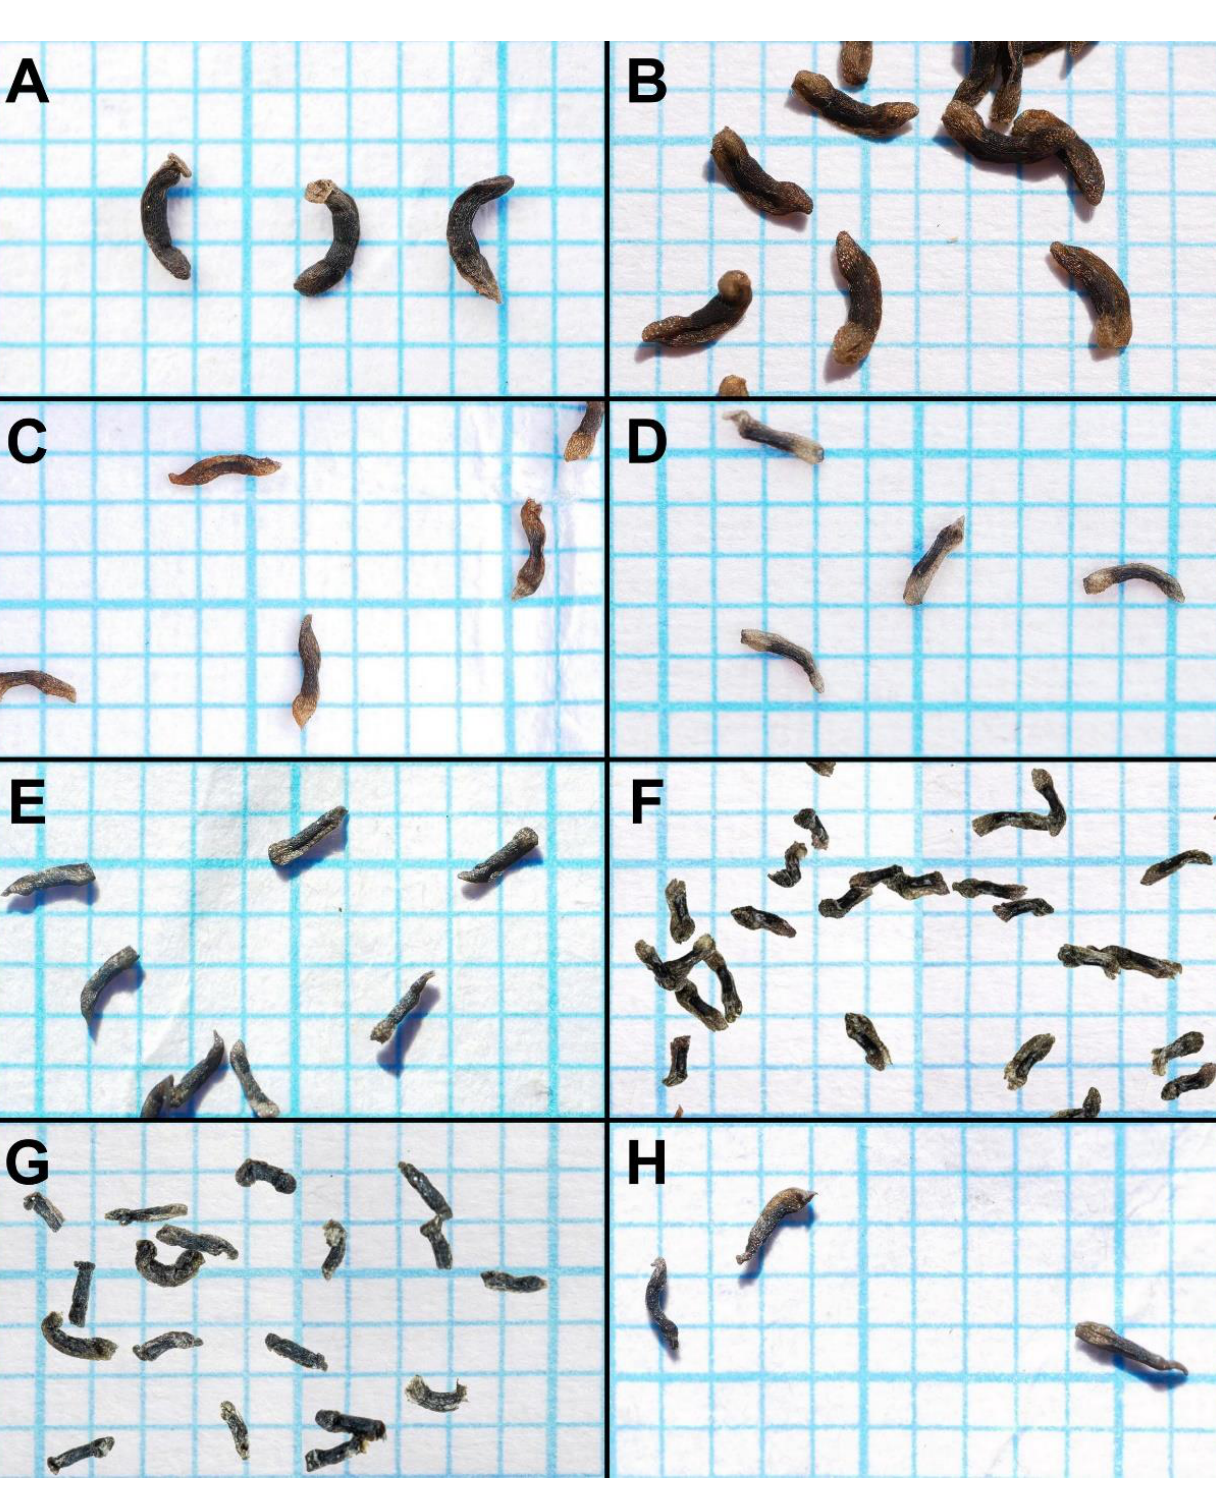
Figure 5. Seed comparison of eight species of the Drosera microphylla complex. Seed is placed on 1 mm grid paper. ( A ) D. atrata ; ( B ) D. calycina ; ( C ) D. esperensis ; ( D ) D. hortiorum ; ( E ) D. macropetala ; ( F ) D. microphylla ; ( G ) D. reflexa ; and ( H ) D. rubricalyx . ( A ) from Coomallo Nature Reserve, Western Australia, 28 August 2021; ( B ) from Roleystone, Western Australia, 7 November 2022; ( C ) from Cape Le Grand, Western Australia, 25 November 2021; ( D ) from near York, Western Australia, 14 October 2022; ( E ) from near Dandaragan, Western Australia; ( F ) from near Walpole, Western Australia; ( G ) from near Kentdale, Western Australia; and ( H ) from near Jurien Bay, Western Australia. ( A – E , H ) by T. Krueger; ( F , G ) by G. Bourke, seed digitally superimposed onto grid paper. Diagnosis: Drosera atrata differs from all other species of the D. microphylla Endl. complex by (contrasting characters in parentheses) (1) its leaf arrangement, with all leaves in groups of 2 – 5 per node due to the presence of 1 – 4 slightly shorter axillary leaves in the axils of all cauline leaves (cauline leaves solitary or axillary leaves only found in the upper 1 – 9 nodes of the stem with the lower 4 – 15 cauline leaves being soli- tary); (2) its many-flowered inflorescences typically producing 5 – 23 flowers per scape (1 – 8 flowers per scape); and (3) its styles, which mainly branch close to their base into entire or sparsely branched style segments (styles branching near their base and style